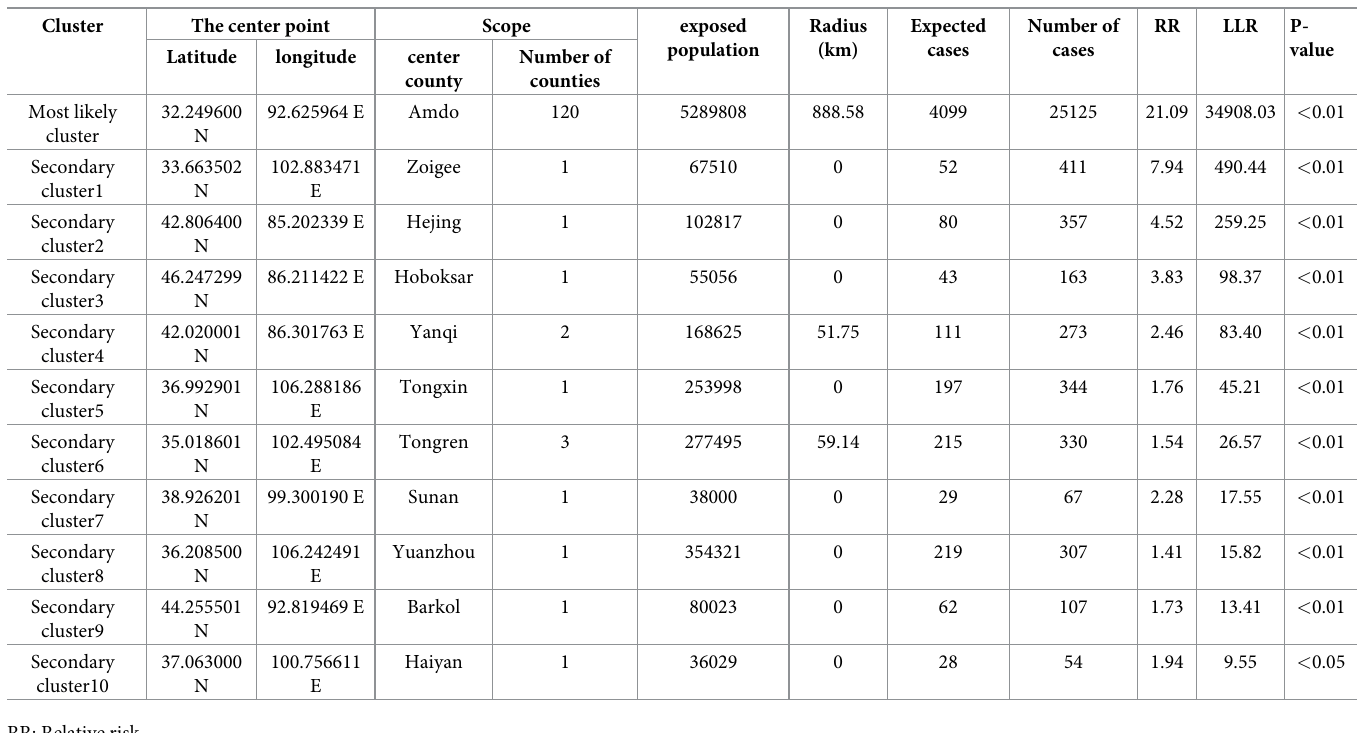
Table 6. Spatial clustering analysis for human CE in